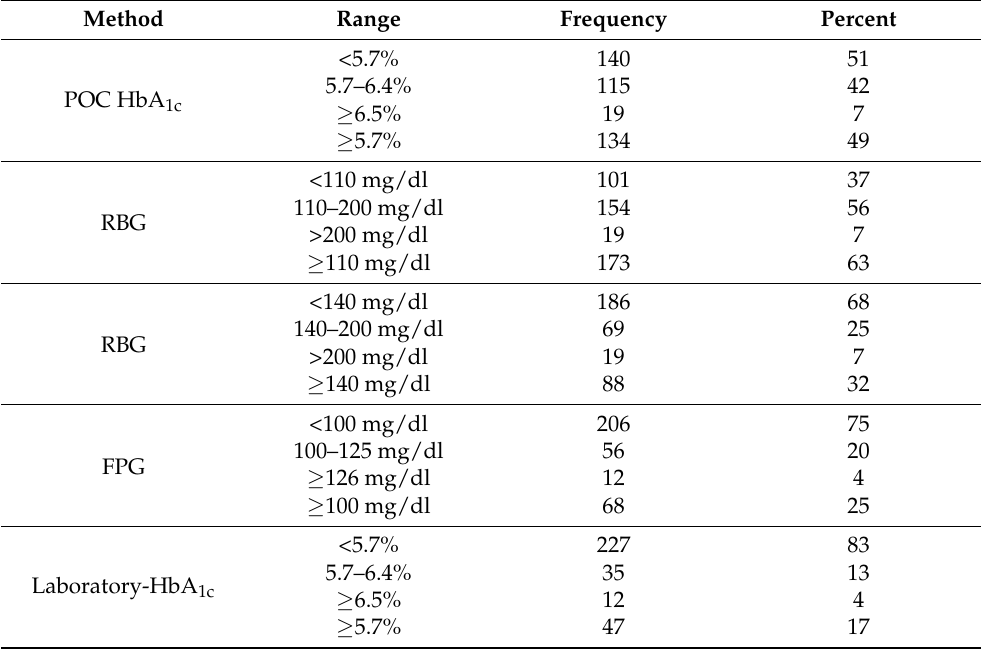
Table 2. Prevalence of hyperglycemia (POC HbA 1c ≥ 5.7%, POC RBG ≥ 110 and ≥ 140 mg/dl), prediabetes and potential type 2 DM according to various methods of detection.